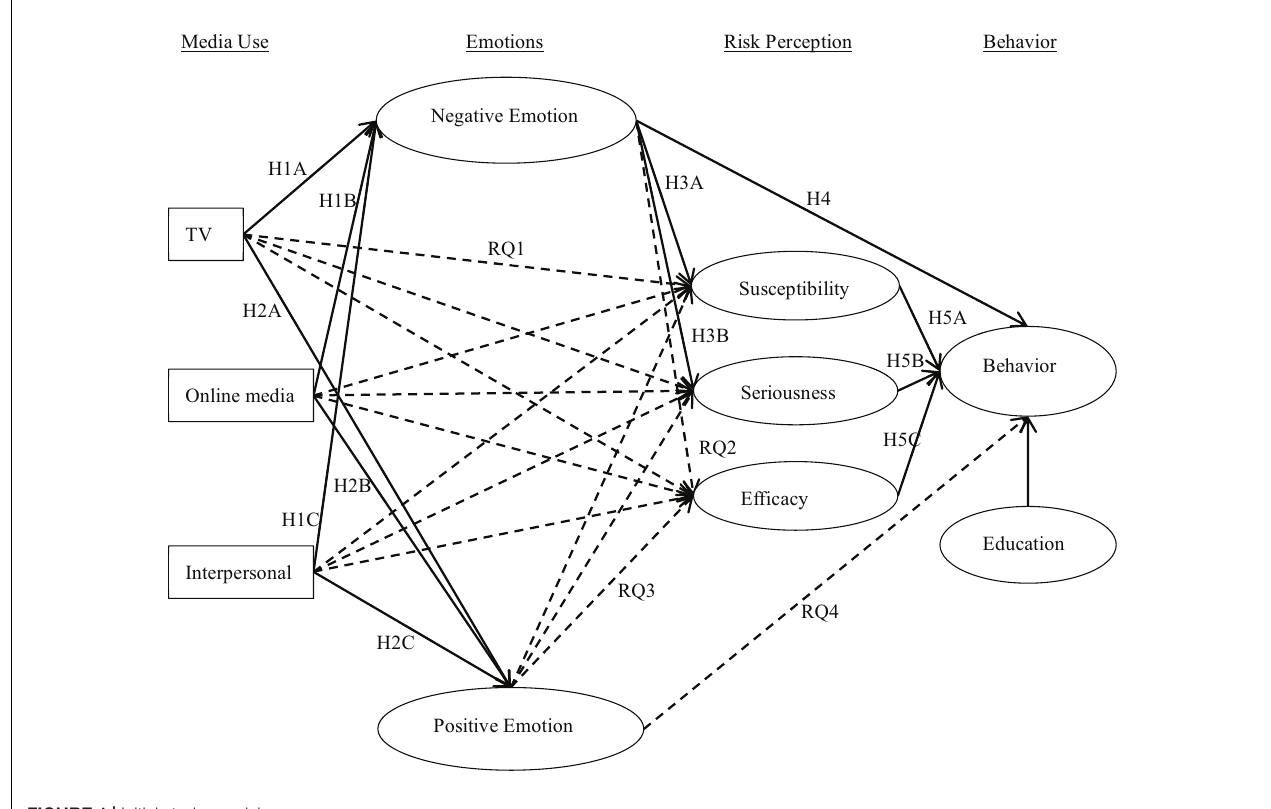
FIGURE 1 | Initial study